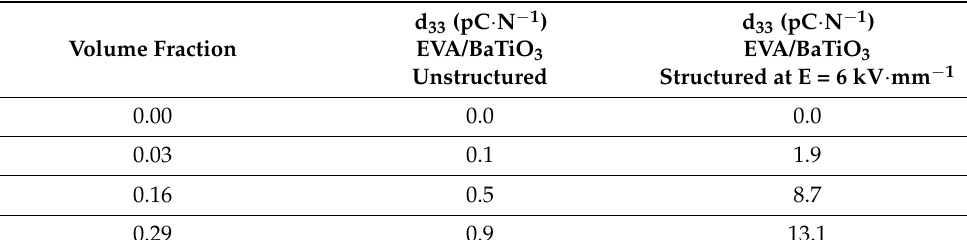
Table 3. Piezoelectric charge coefficient ( d 33 ) versus filler volume fraction of structured (1–3) and